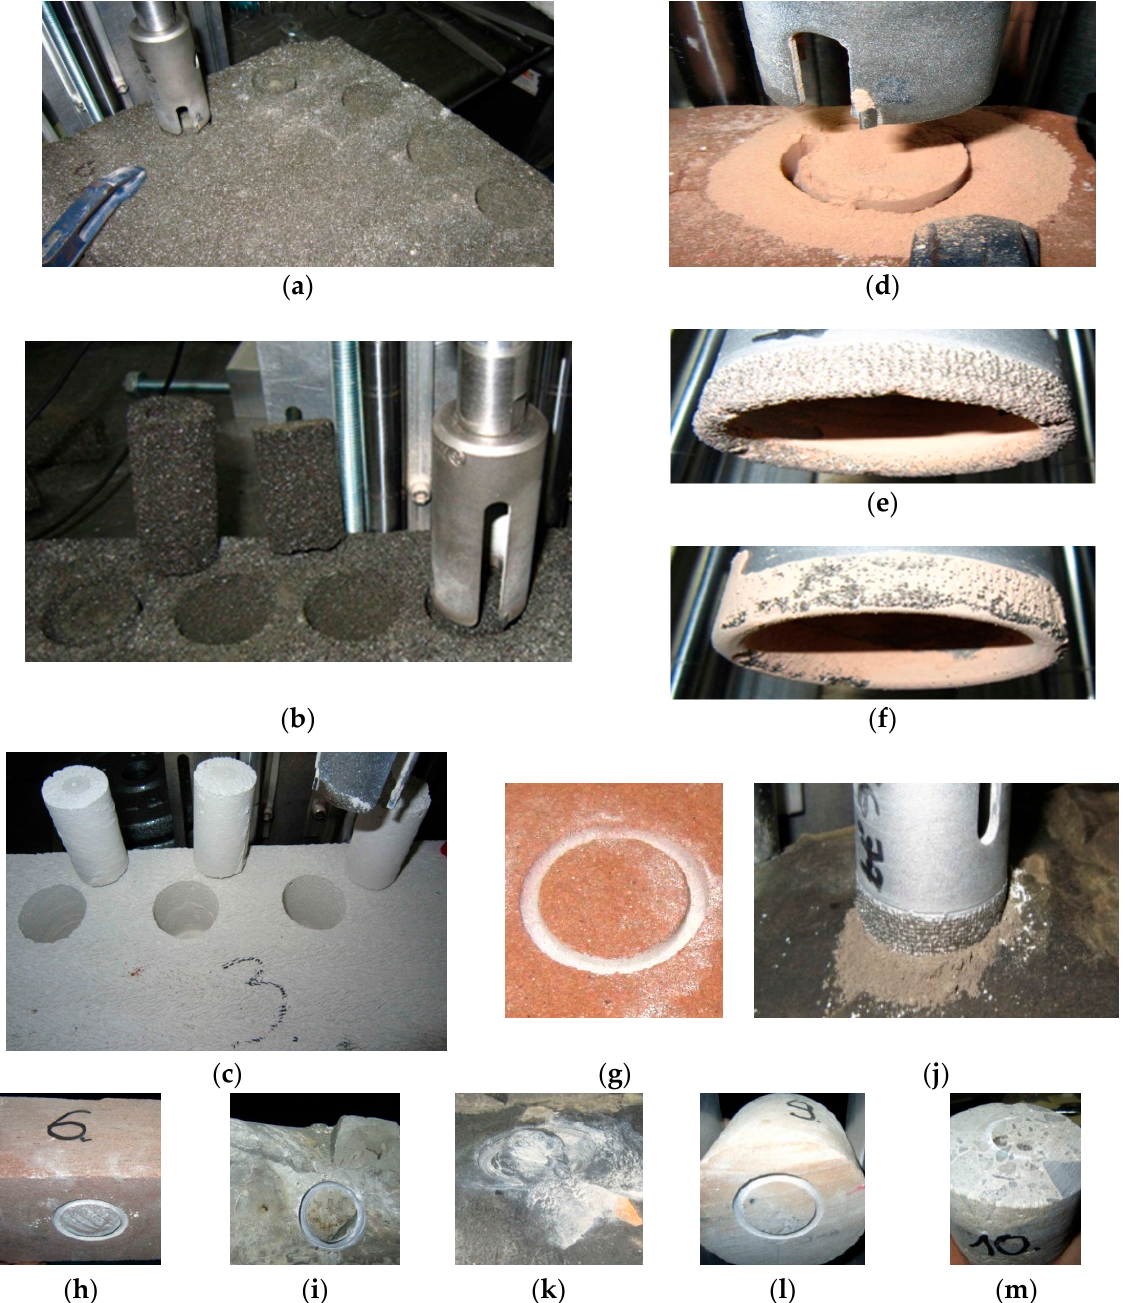
Figure 11. Drillability tests results: ( a ) for sample 1 (grey foamglas F) using Makita coring bit, WOB = 27.27 N; ( b ) for